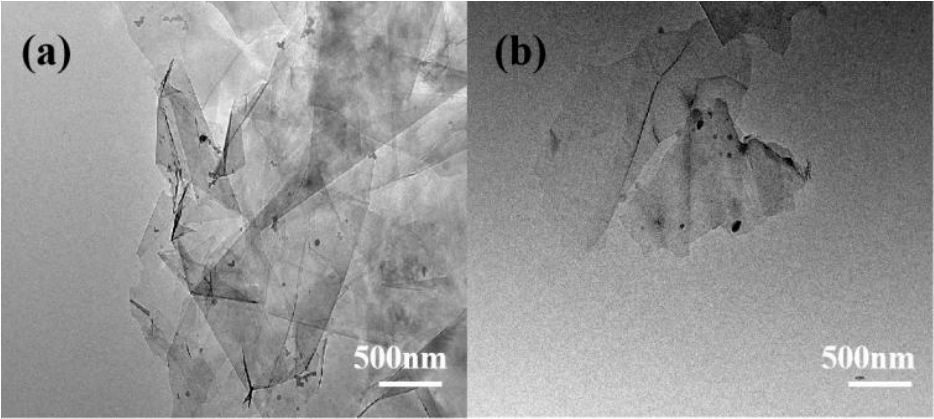
Figure 5. ( a ) Graphene/PVA-g-PANI ink; graphene/PVA-g-PANI ink at different substrates: ( b ) BOPP, ( c ) PI, ( d ) PET, and ( e ) A4 paper; SEM images of the film prepared with graphene/PVA-g- PANI ink: ( f ) section and ( g ) surface images. When the ink has appropriate rheological characteristics, we can obtain the printing pattern that has more smooth edges and a higher resolution through screen-printing tech- nology. Furthermore, the defects and bubbles in the printing patterns must be eliminated, and the conductivity of the printing patterns must be improved. In Figure 6a, the viscosity of the graphene dispersion decreases with the increase in the shear rate, indicating that graphene dispersion has a significant shear-thinning behavior, which is beneficial for the extrusion of graphene dispersion in the printing process. The modulus recovery of